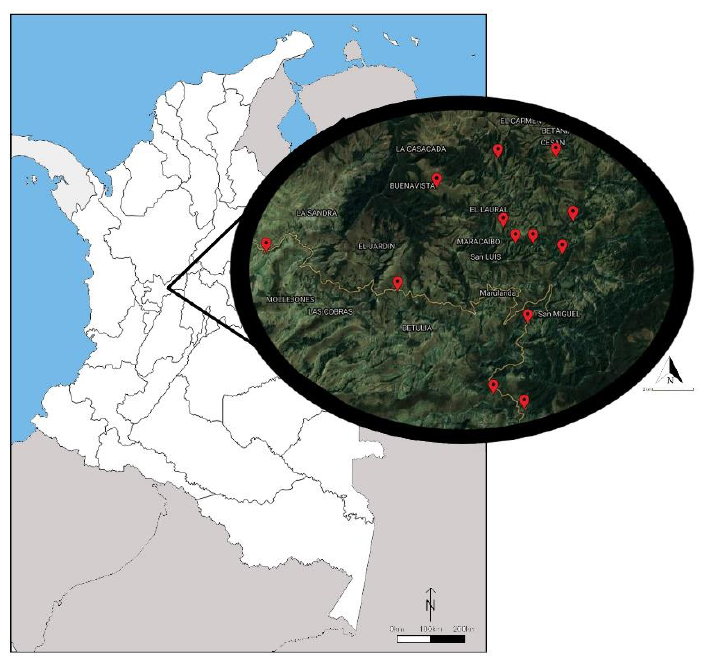
Figure 1. Geo-referencing of rural farms evaluated in Marulanda, Caldas, Colombia.